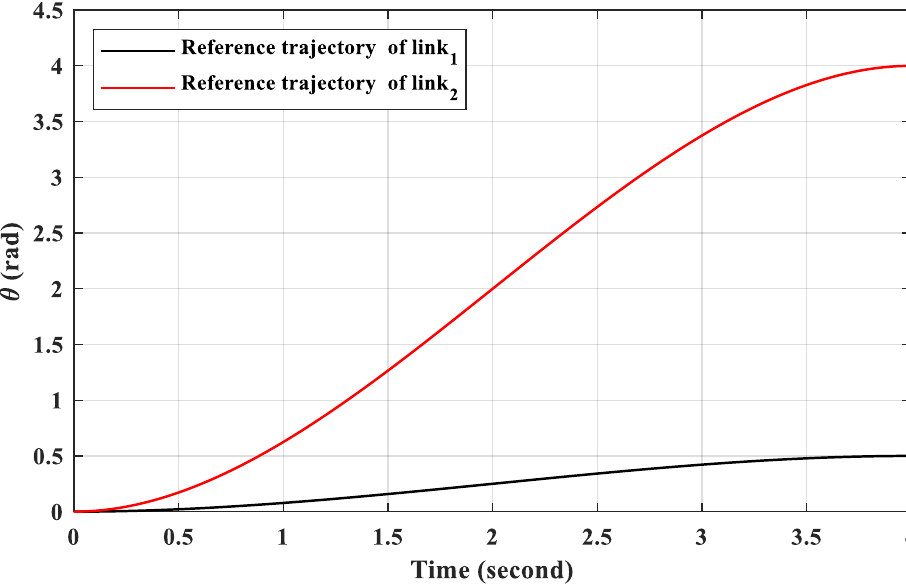
Figure 8. The cubic references for each robot link.